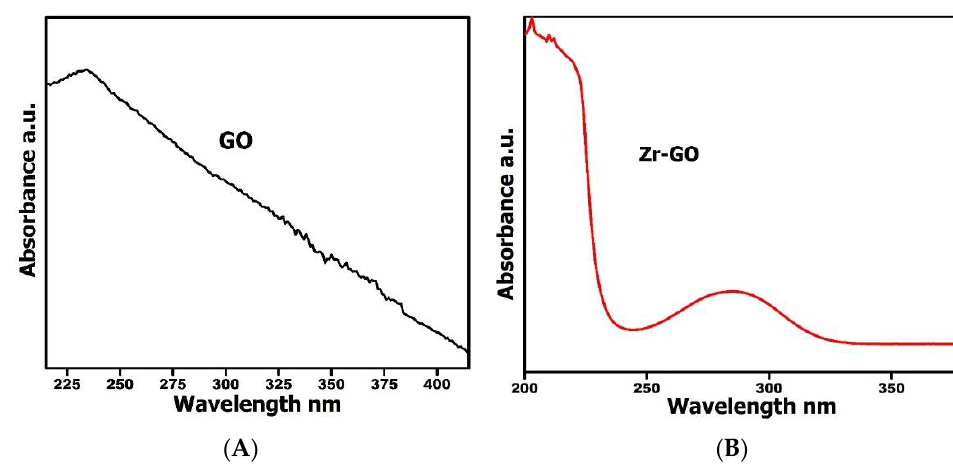
Figure 1. UV-Visible spectra of ( A ) Zr and ( B ) Zr-GO composite in aqueous solution. Fourier transform infra-red spectroscopy was deployed to fingerprint the identified elements existing in the sample. Figure 2 represents the FTIR spectra of GO and of the Zr-GO composite. In the GO spectrum, a broad absorption band established at around 3200 cm − 1 was assigned to the stretching vibration of OH, which likely contributed to the water adsorbed on the GO surface [25]. Some absorptions were noticed at 1620 cm − l (C=O), 1386 cm − l (C=C), 1222 cm − l (COOH), and 1040 cm − 1 (C-O-C), evidencing the oxidation of graphite into GO [26]. As for the spectrum of Zr-GO, the peak at 3200 cm -l corresponded to stretching vibration of OH which corresponded to the presence of water molecules formed in accordance with hydrogen bond formation [27]. The peak at 1575 cm − 1 could be attributed to deformation vibrations of Zr-OH. The peak at 987 cm − 1 could probably be ascribed to the presence of ZrO bending vibrations [2,26]. The concentration of ZrCl 4 was kept high in the GO solution (~80:20) to get enough Zr moieties on the GO matrix. These Zr moieties possibly removed some of the oxygen from the GO sheets to sit on those sites. This removal could be evidenced by the significant reduction of typical intensities of some of the oxygen-containing GO peaks in the Zr-GO spectrum [27]. These findings illustrated the successful furnishing of the GO surface with Zr, and confirmed that the Zr-GO composite had indeed been